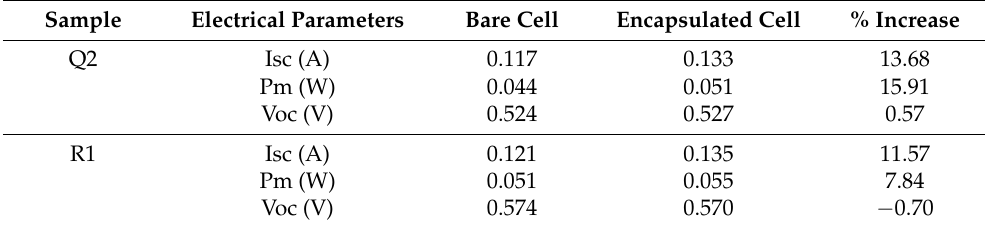
Table 5. Electrical parameters of Q2 sample before coating (bare cell) and after coating and encapsu- lation, compared to reference sample R1 before and after encapsulation. The incident simulated solar light was reduced by a blue filter SCHOTT